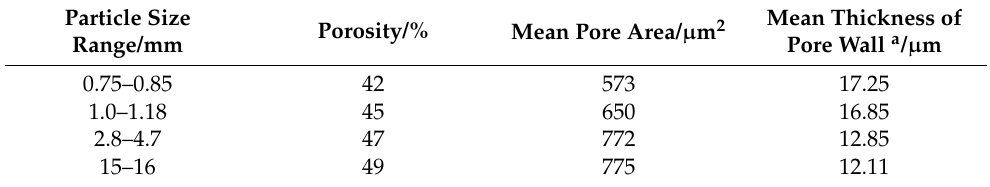
Figure 8. An example of the determination of pore parameters in a coke matrix: ( a ) original image; ( b ) measurement process [69]. Table 6. Pore parameters of coke with different sizes by optical microscope analysis [69].